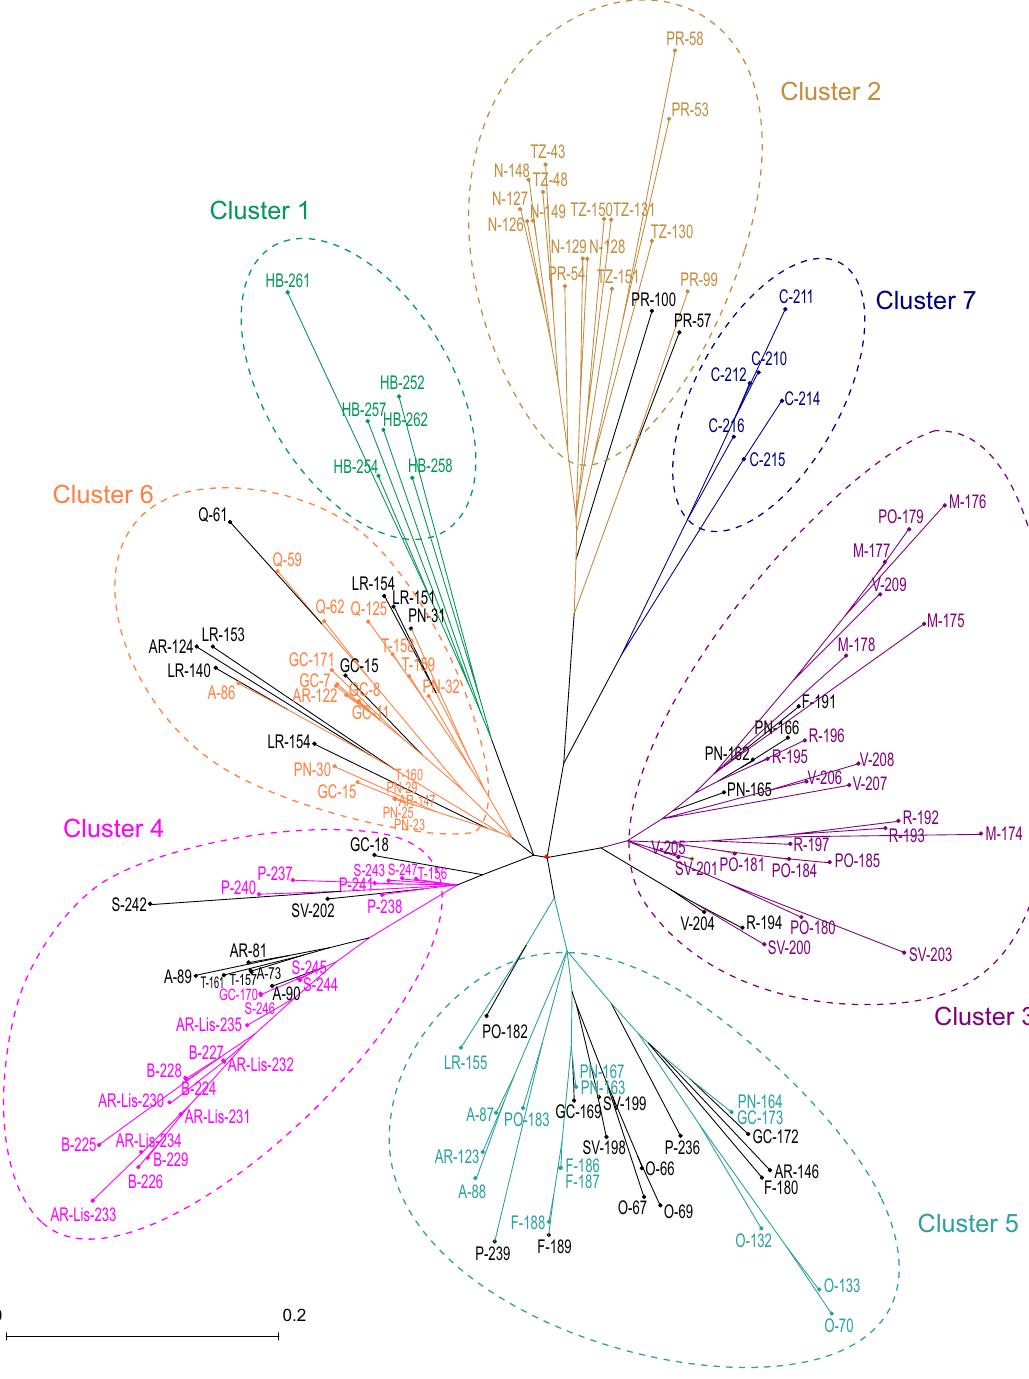
Figure 5. NJ tree under topological constraints showing the phylogenetic relation among the populations of T. erytreae sampled in newly invaded areas in Spain and Portugal and those from old invaded areas in Kenya and South Africa, respectively. Dendogram is the result of 10,000 iterations of allelic data obtained for the ten SSR loci developed in this work. Structure of the tree inferred from allelic data of individuals with Q > 0.7 according to STRU CTU RE 37 was used as initial tree, and the remaining individuals were positioned (constraint) on this previous topology. Spain: Aldán (A), Areeiro (AR), Gran Canaria (GC), Los Rodeos (LR), Oratava (O), Portonovo (PN), Tacoronte (T). Portugal: Areeiro-Lisbon (AR-Lis), Barreiralva (B), Camacha (C), Farrobo (F), Moreno (M), Paião (P), Poiso (PO), Quebradas (Q), Ribamar (R), Sobreda (S), São Vicente de Pereira Jusã (SV), Vairão (V). South Africa: Nelspruit (N), Pretoria (PR), Tzaneen (TZ). Kenya: Homa Bay (HB). Genetic clusters for K = 7 are indicated. Admixed individuals with Q < 0.7 are shown in